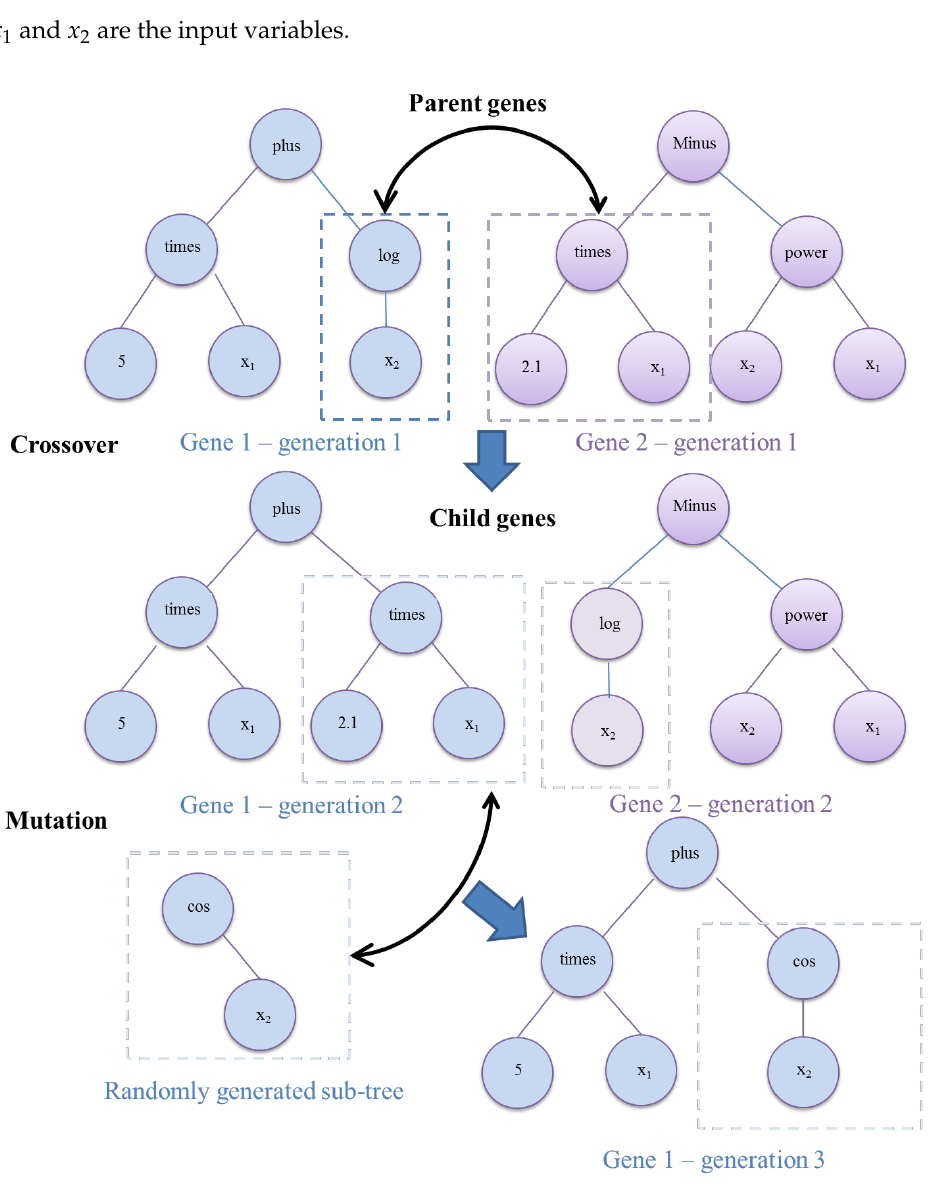
Figure 2. Example of the tree structure and evolving processes of an MGGP chromosome.